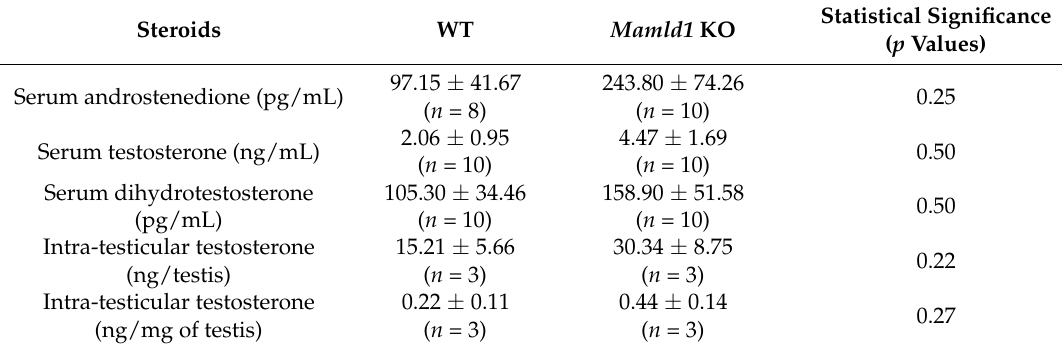
Table 4. Steroid hormone levels of mice at 8 weeks of age.